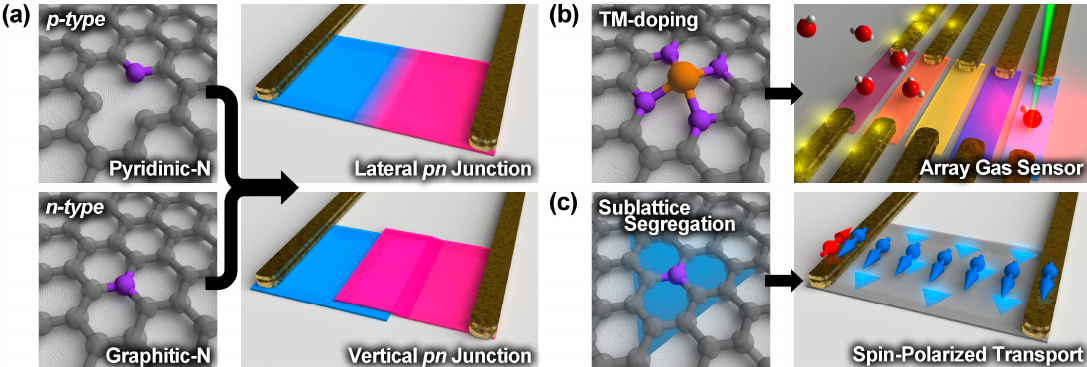
Figure 5. Possible device structures for NGs with different nitrogen dopant configurations. ( a ) Lateral and vertical p-n junctions for photodetection using pyridinic-N and graphitic-N as p- and n-type semiconductors, respectively. ( b ) Array gas sensor made by NG doped with several different transition metals (TMs). Differently colored sheets correspond to NG with different TMs. Different TMs act as the active sites and provide different sensitivity and selectivity to the sensor. By monitoring electric conductivity, optical signature, and the signal pattern, adsorbed gas type and concentration will be determined. ( c ) NG with sublattice segregated nitrogen dopants used as part of a spin polarized transport device.